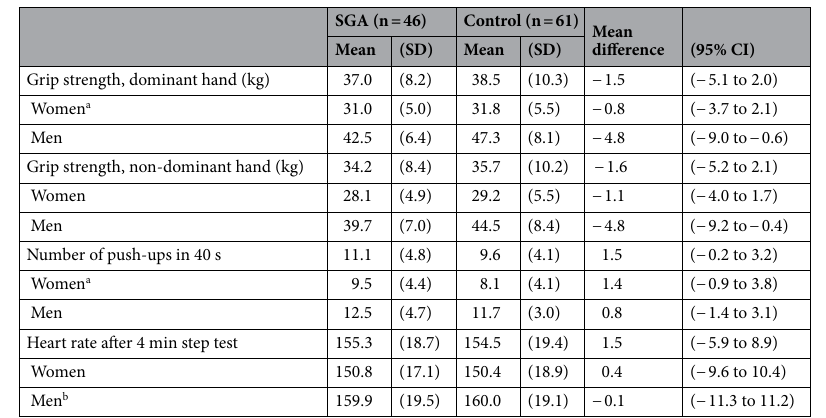
Table 3. Physical fitness of adults born small for gestational age (SGA) and non-SGA (control) at term. CI confidence interval, SD standard deviation, SGA small for gestational age. a Data missing for one control due to a hand fracture. b Data missing for two participants born SGA who could not complete the